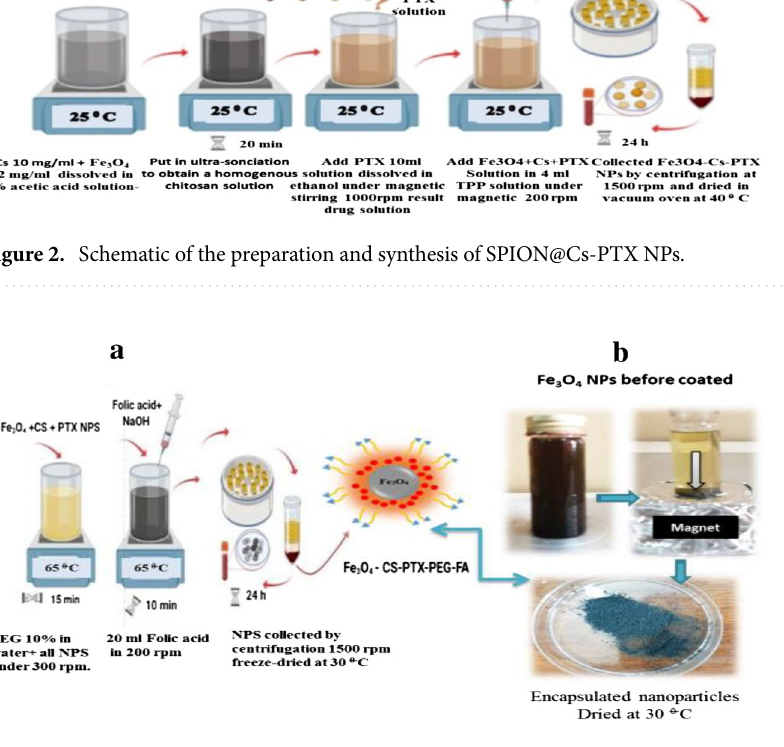
Figure 3. ( a ) Schematic of the preparation and synthesis of SPION@Cs-PTX-PEG-FA NPs, and ( b ) photos during their preparation in the